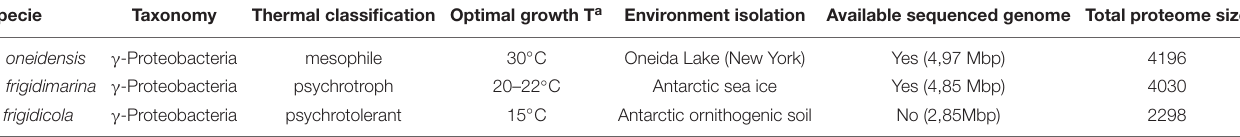
TABLE 1 | Main features of the species used. Specie Taxonomy